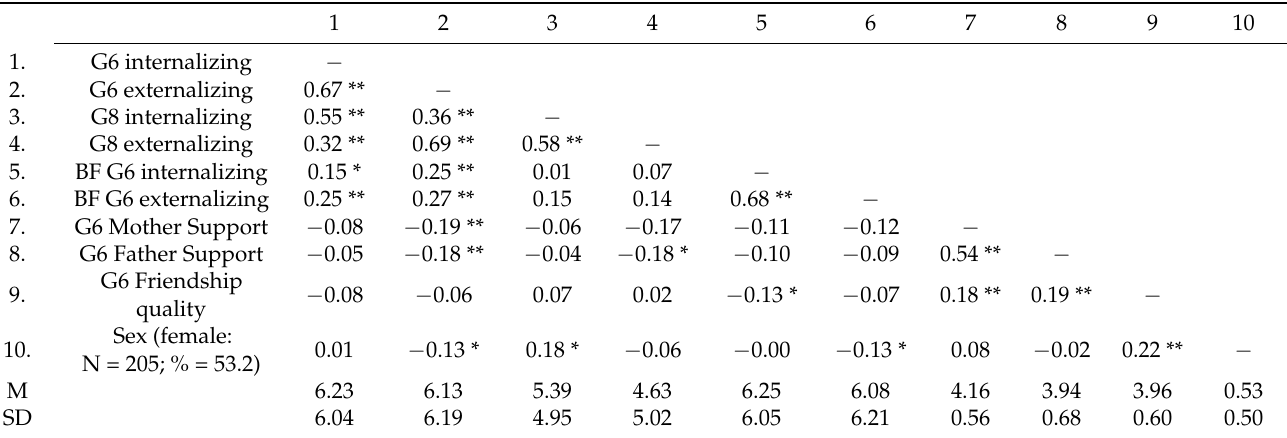
Table 1. Summary of intercorrelations, means and standard deviations on key study